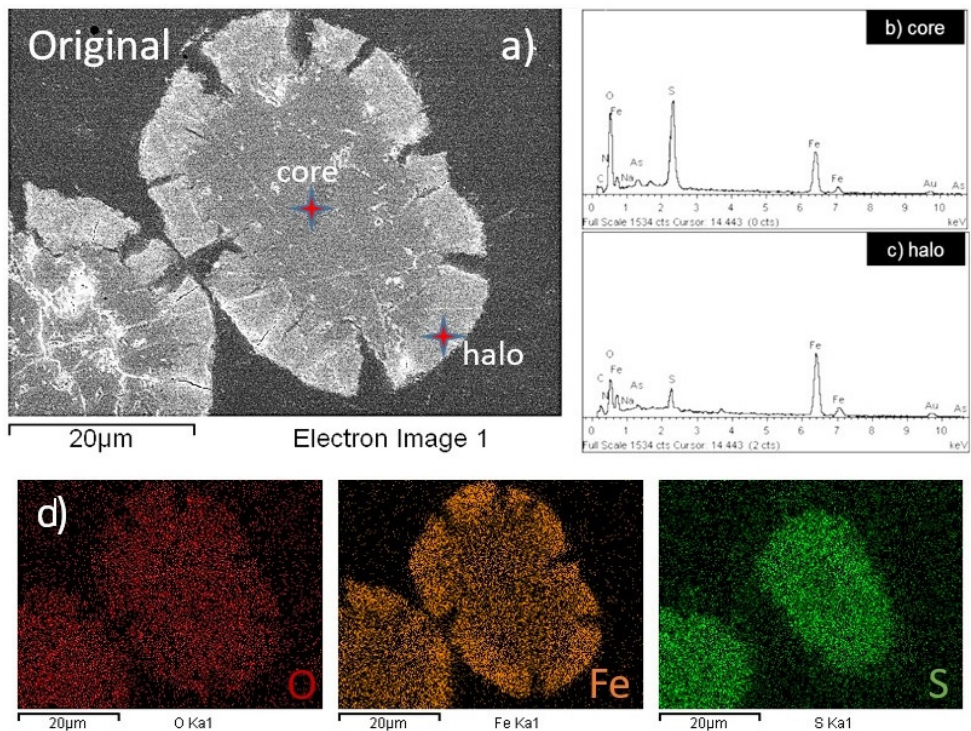
Figure 5. ( a ) SEM-BSE image of a partially decomposed particle of ammonium-sodium jarosite with arsenic in NaOH media; pH = 12.85, 303 K (30 °C), d 0 = 38 µm, RPM = 500 min − 1 , 8 min of reaction, ( b ) EDS analysis corresponding to the core, and ( c ) EDS analysis corresponding to the ash layer in Figure 5a. ( d ) Energy dispersive X-ray mapping of the elements in greater proportion according to the EDS spectrums. Results show that a shrinking core kinetic model satisfactorily describes the decomposition process in alkaline medium of the ammonium-sodium jarosite with arsenic studied.